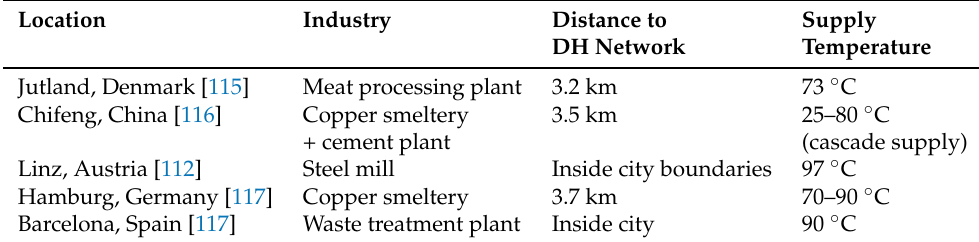
Table 6. Key information of some excess heat based DH systems